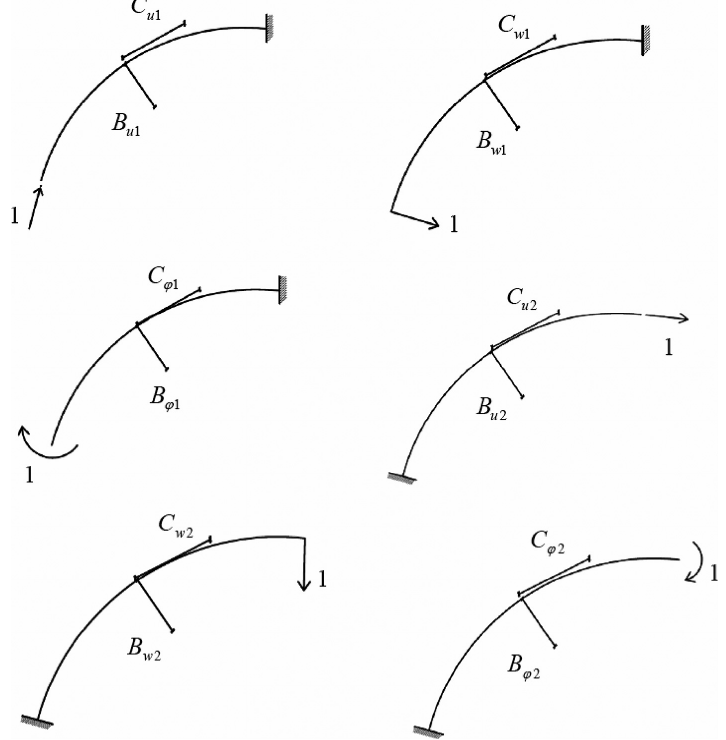
Fig. 4. Illustration of equivalent Basic Displacement Functions.